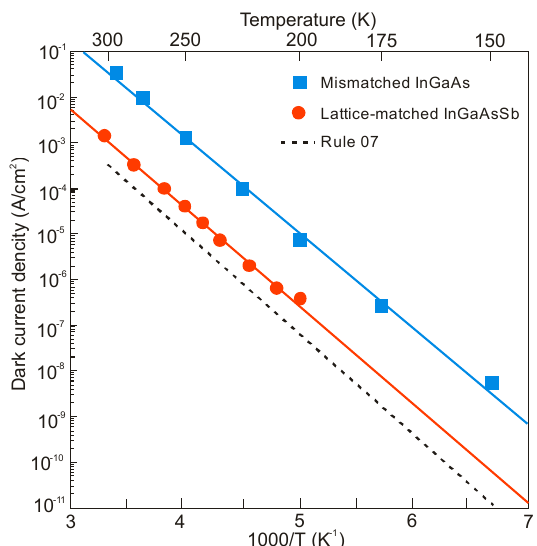
Figure 66. InGaAs and InGaAsSb nBn dark current comparison. The lattice matched InGaAsSb barrier detector exhibits at least an order of magnitude reduction in the dark current in comparison to the mismatched InGaAs nBn detector (after [195]).